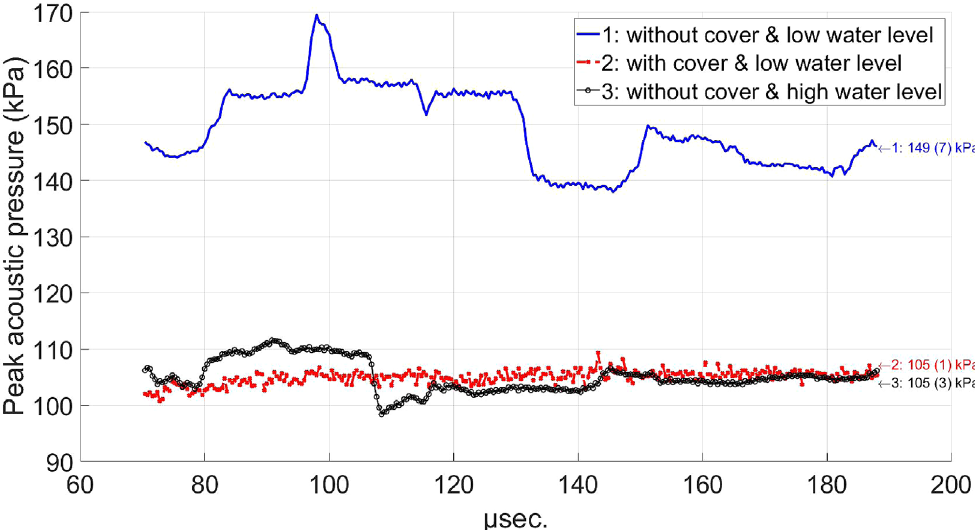
Figure 8. Moduli of the Hilbert transform of the transmitted RF-signals between the 1 MHz-transducer and the hydrophone in horizontal position and a low water level above the Petri dish, and the hydrophone in vertical position and a high water level. On the right, the mean values and standard deviations are mentioned.